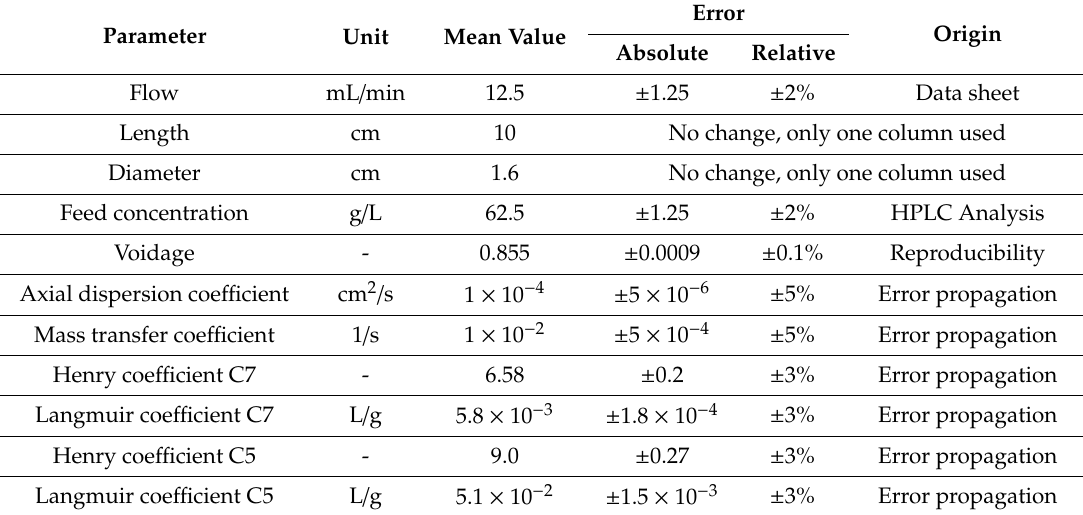
Table 4. Parameters for the center point